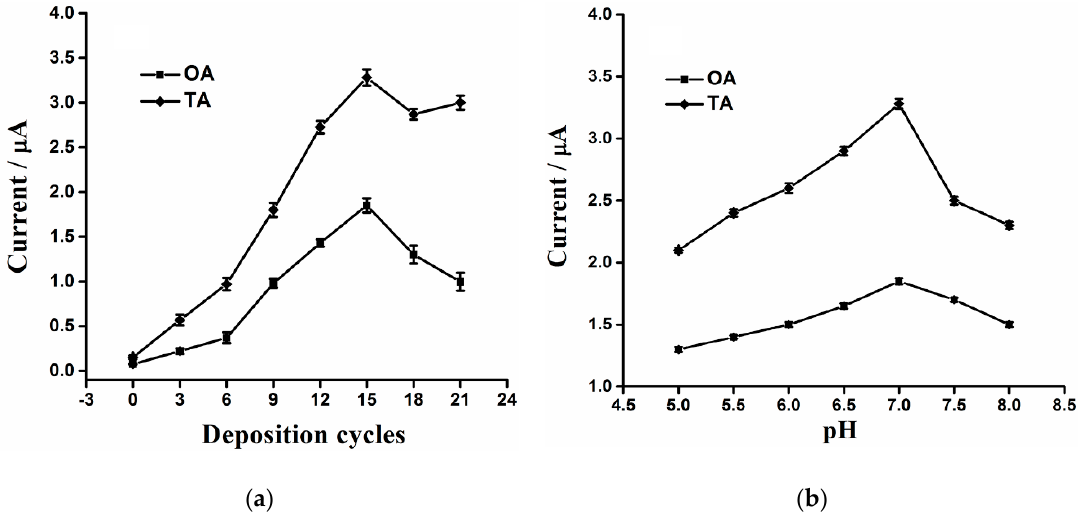
Figure 6. ( a ) The influence of graphene depositing cycles (0, 3, 6, 9, 12, 15, 18 and 21 cycles) on the